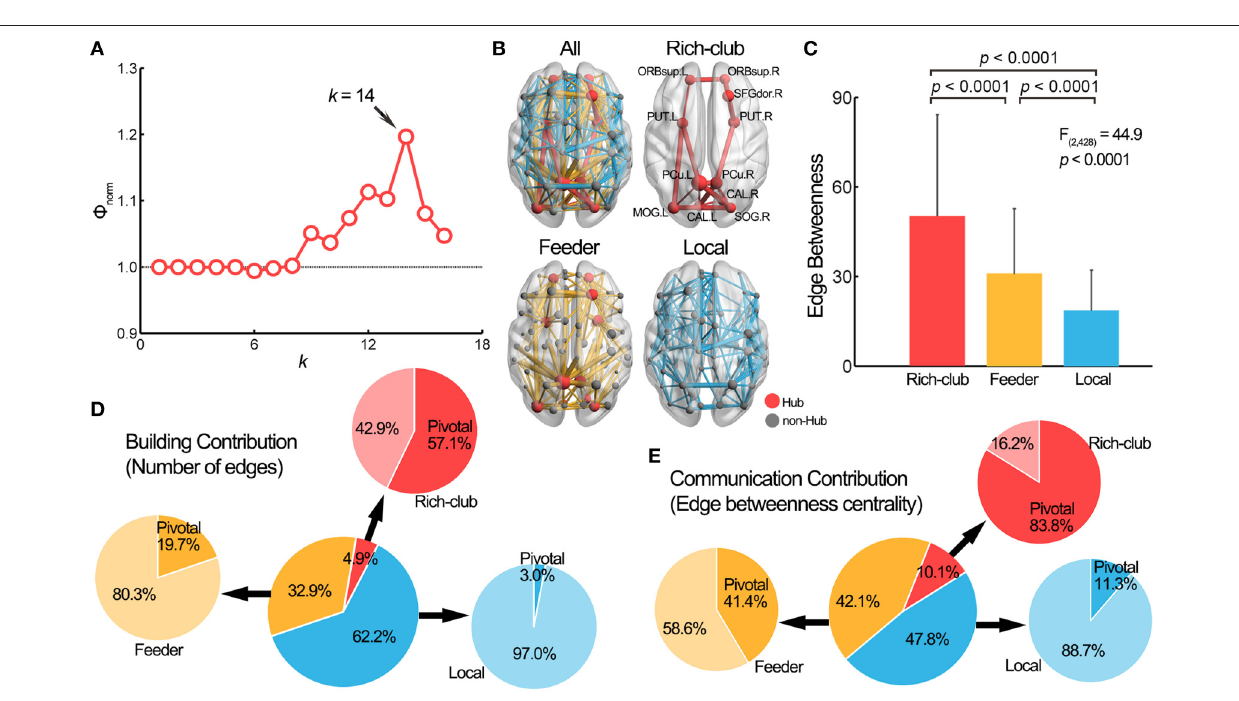
FIGURE 4 | Pivotal edges and the rich-club structure. (A) The normalized rich-club coefficient 8 norm ( k ) of the group-level WM network was above 1 for a range of k from 9 to 16. The peak at k 14 was selected as the hub threshold for further analysis. (B) The network hubs were mainly located in the medial line of the brain = and the connections of the brain network can be further classified into three categories: rich-club (red), feeder (yellow) and local (blue) connections. (C) The edge betweenness centrality values were significantly different among rich-club, feeder, and local connections. (D) The pivotal edges had significantly different building contribution (indicated by the proportion of number) to three categories of connections. (E) The communication contribution (indicated by the proportion of edge betweenness centrality), of the pivotal edges was also significantly different among three categories of connections. The center pie illustrates the building/communication percentage of the three types of connections, and the surrounding pies show the building/communication percentage in each category of the connections. SFGdor, superior frontal gyrus, dorsolateral; CAL, Calcarine fissure and surrounding cortex; L, left; R, right. For other abbreviations, see Figure 2